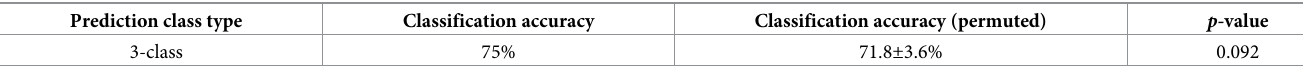
Table 5. 3-class classification accuracy of SRM substances excluding sample